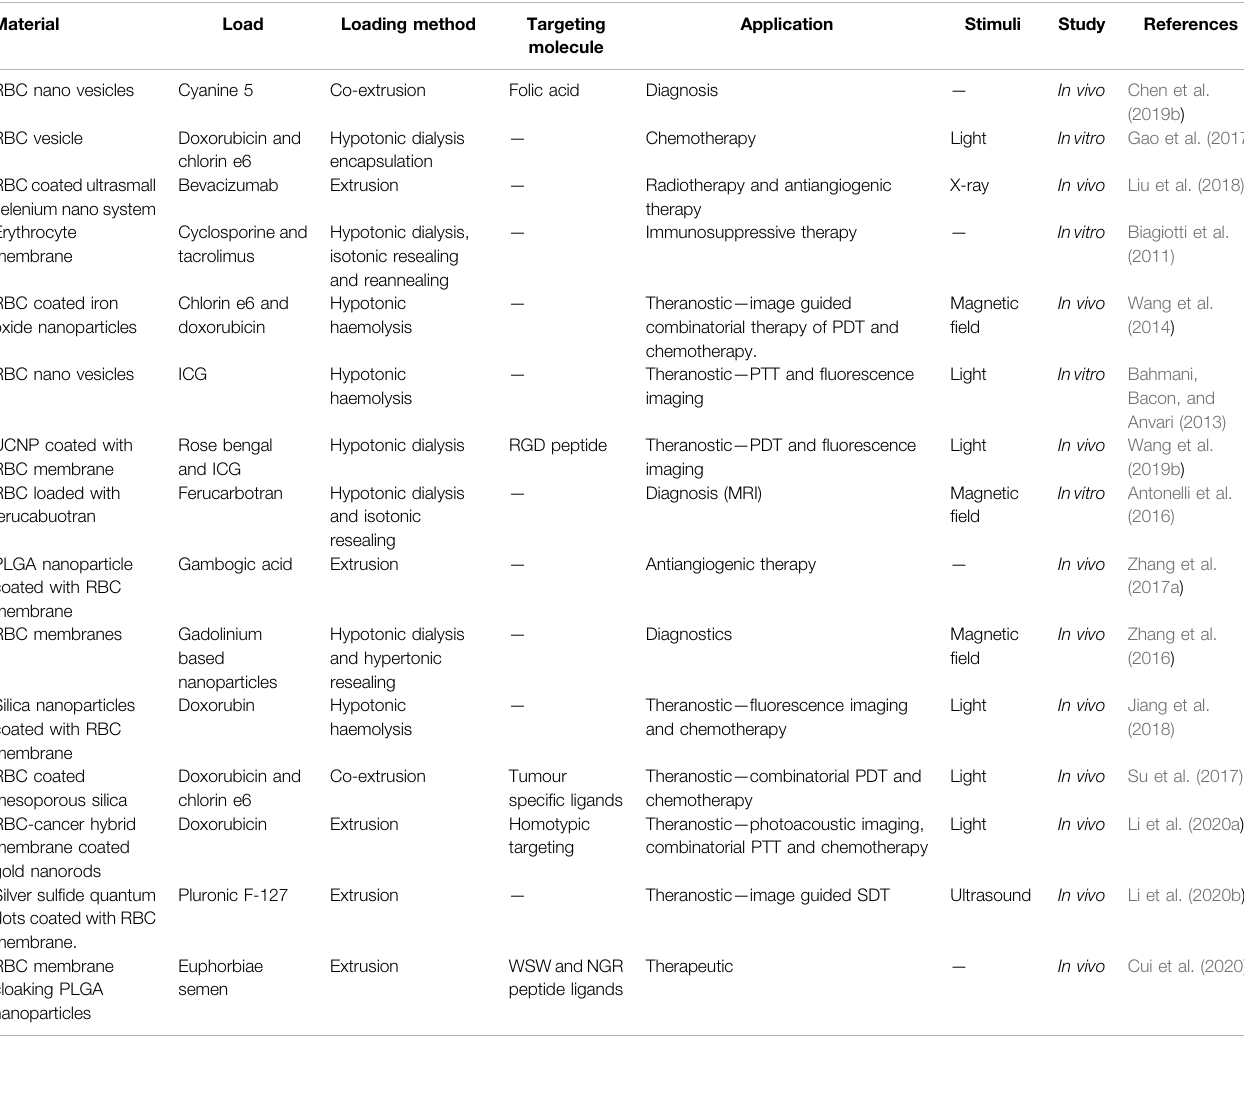
TABLE 1 | Biomedical applications of RBC-based drug delivery systems.